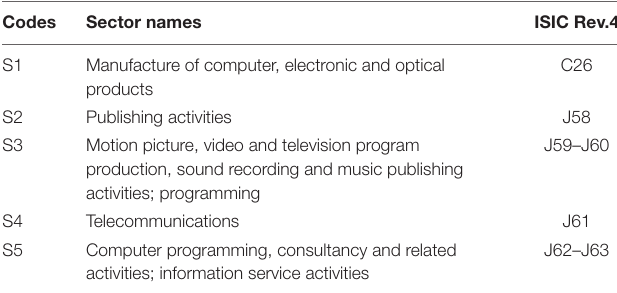
TABLE 2 | Information and communication technologies sectors in WIOD.